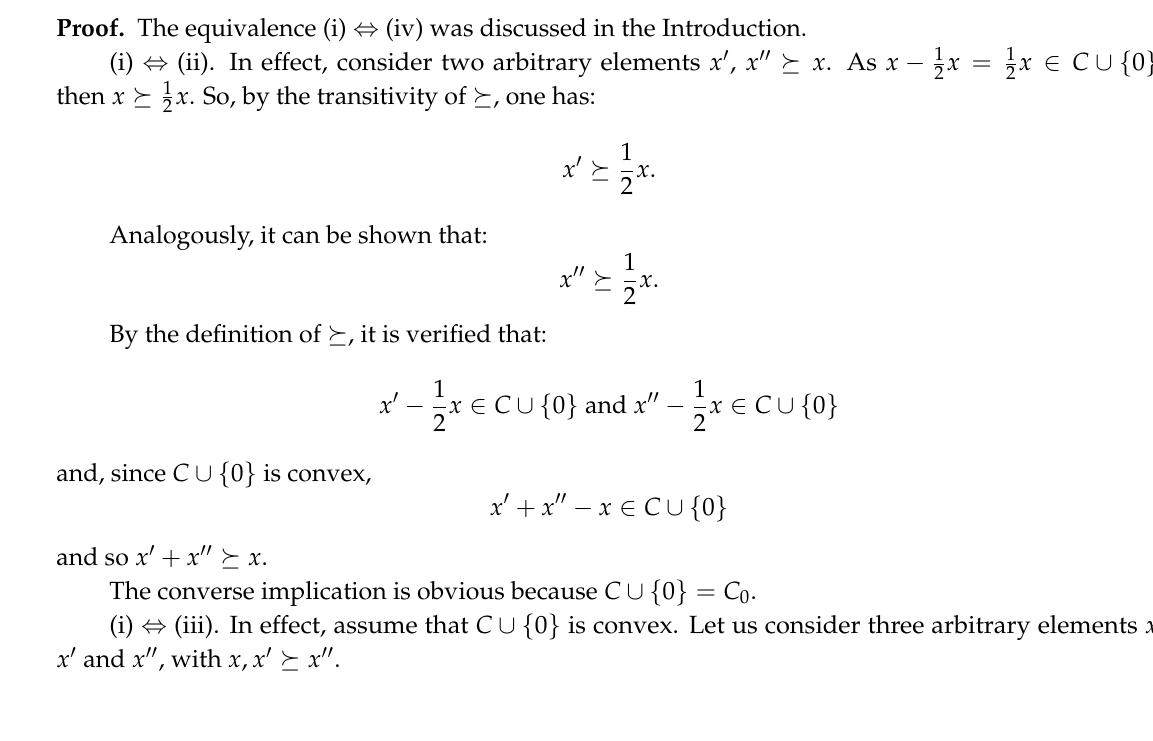
1,2 ). Source: Own elaboration. Figure 6. Indifference lines (case in which I = { 1,2 } ). Source: Own { }